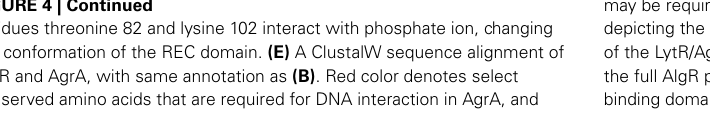
may be required for AlgR interaction with DNA. (F) An illustrated model depicting the location of conserved amino acids on the secondary structures of the LytR/AgrA DNA-binding domain of AlgR. (G) A stereoscopic view of the full AlgR protein modeled, using CheY structure and S. aureus AgrA DNA binding